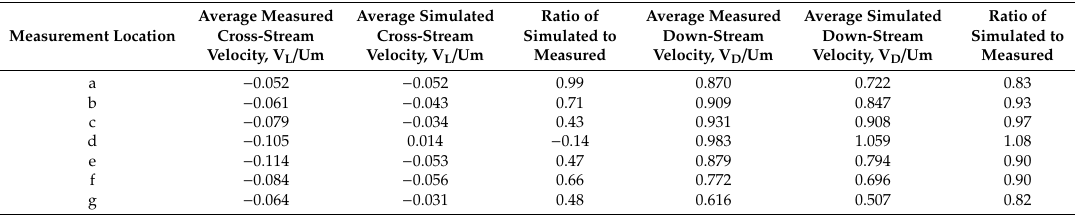
Table A5. Summary comparison of simulated and measured velocities at Cross-section 6 using the finest model mesh size (492 × 42 × 32).